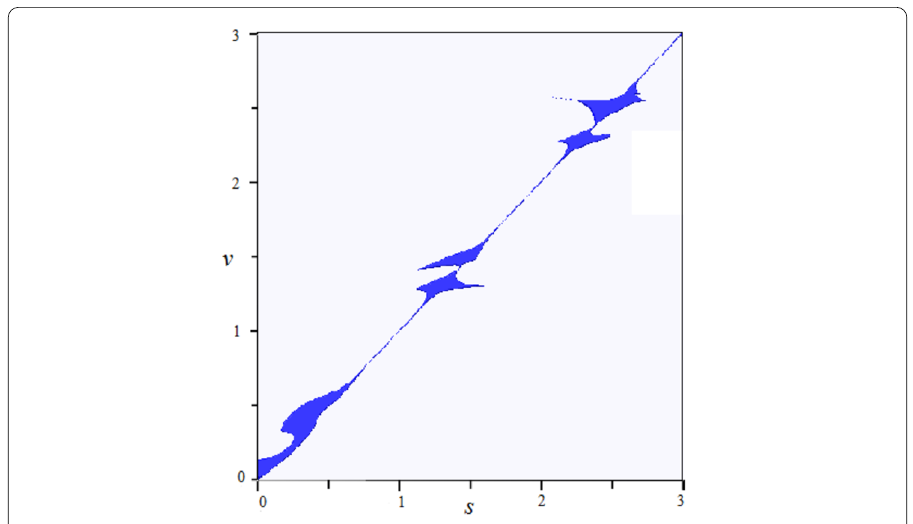
Figure 1 The periodicity region of the new